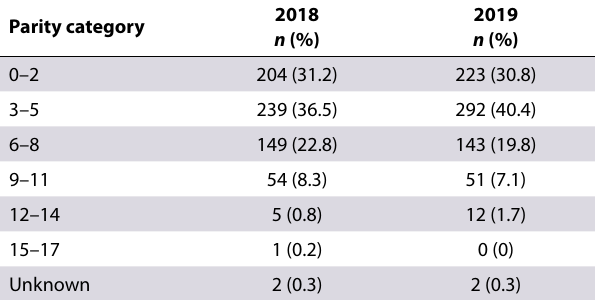
Table II: Parity category of Thoroughbred barren mares tested as part of the South African stud health scheme in 2018 ( n = 654) and 2019 ( n = 723) Parity category